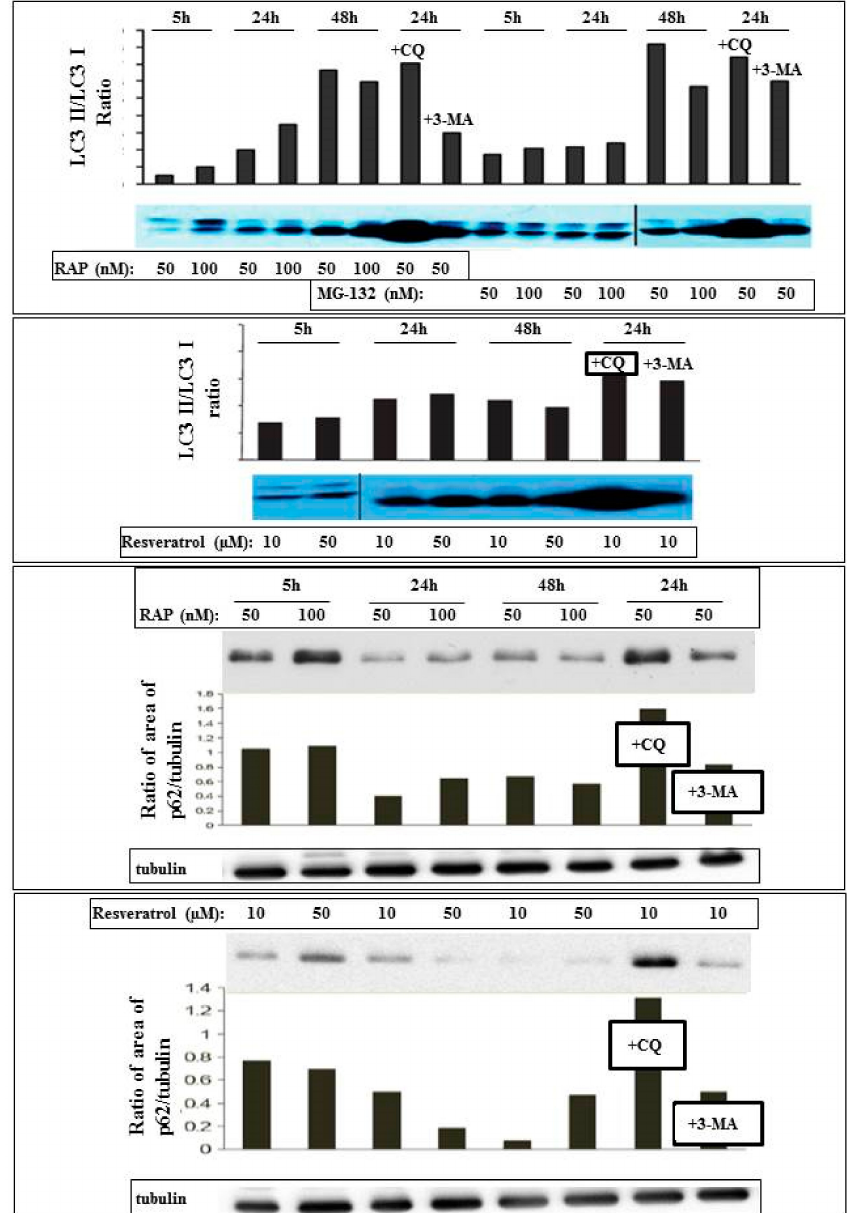
Figure 2. Detection and quantification of autophagy in ARPE-19 cells using Western blot analysis. The cells were treated in a time- and concentration-dependent manner by the autophagy inducer rapamycin (RAP), proteasomal inhibitor MG-132, and Resveratrol. The LC3II / I ratio and expression of p62 are shown, as well as the e ff ect of the autophagosome-lysosome fusion inhibitor chloroquine (CQ) and the upstream inhibitor of autophagy 3-methyladenine